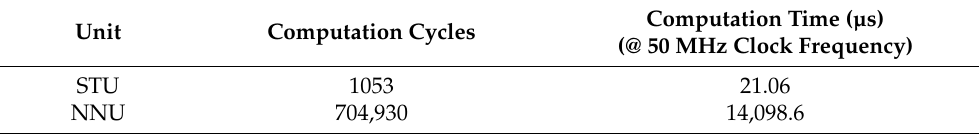
Table 6. Computation cycles and time for the proposed HGR system.